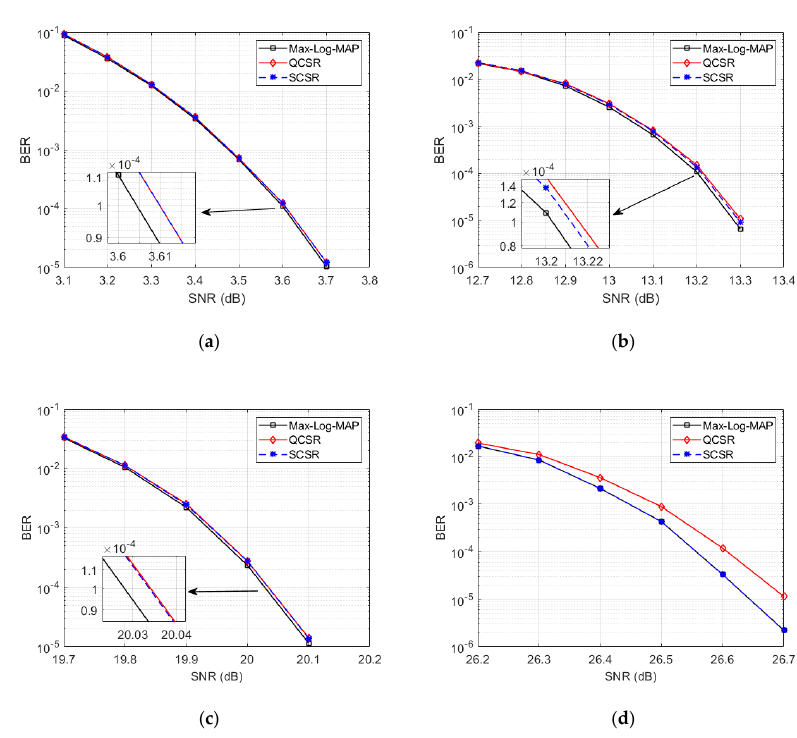
Figure 6. BER Performance comparison of Max-Log-MAP, QCSR and SCSR algorithms over i.i.d Rayleigh channel. Results presented for 2D-256NUCs. ( a ) CR = 2/15; ( b ) CR = 6/15; ( c ) CR = 10/15; ( d ) CR = 13/15.